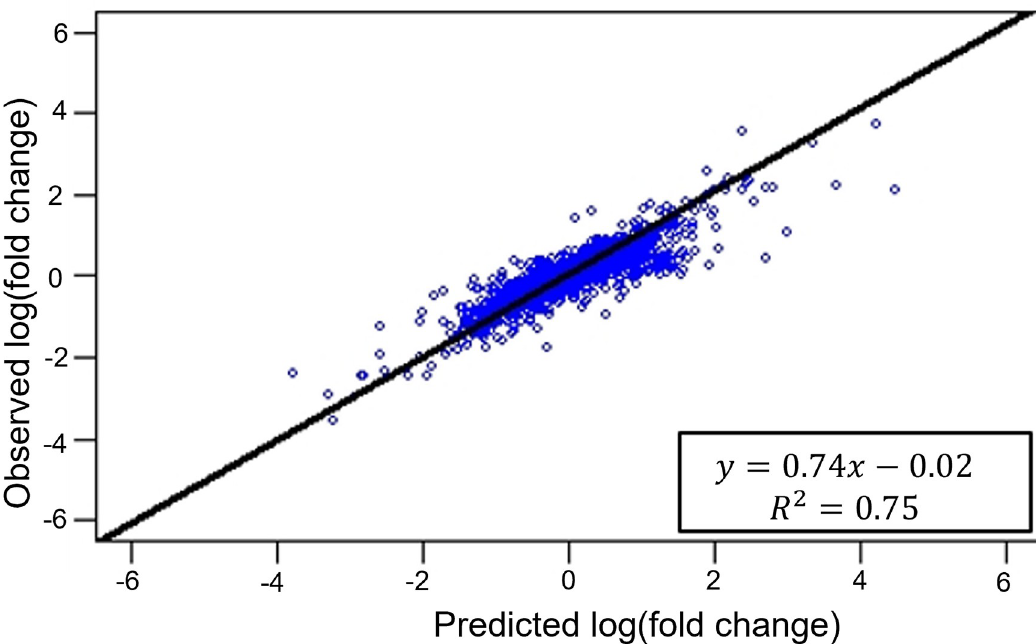
Fig 3. Correlation between the predicted and observed log-fold changes in gene expression among MAP2K1 and MAP2K2 neighbor genes in the protein-protein interaction (PPI) network.